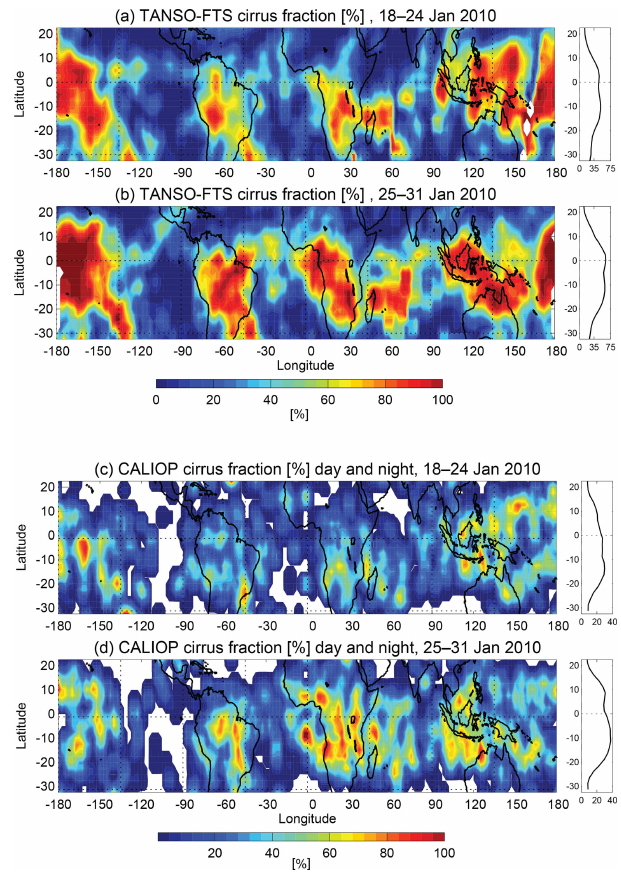
Figure 9. Maps of cirrus cloud occurrence frequency from the TANSO-FTS water vapor saturated method and CALIOP plotted for 2.5 ◦ boxes. (a, c) On 18 and 24 January and on (b, d) 25 and 31 January. Both datasets were smoothed using 3-grid box smoothing. Panels to the right of the maps show the zonal mean